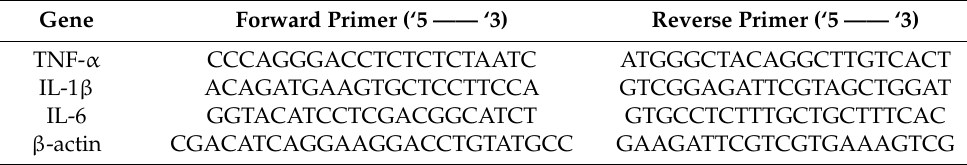
Table 1. Forward and reverse primers sequence for investigated pro-inflammatory genes.